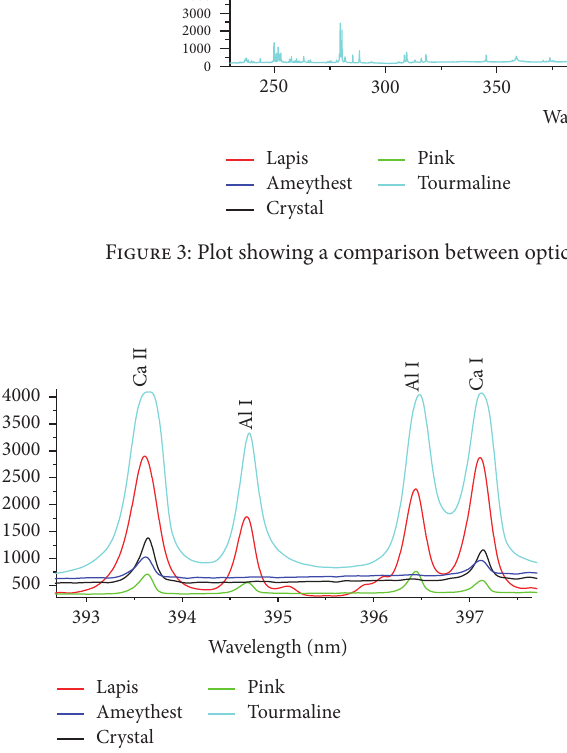
Figure 4: Optical emission spectrum showing Al I and Ca I, II transition in all five types of